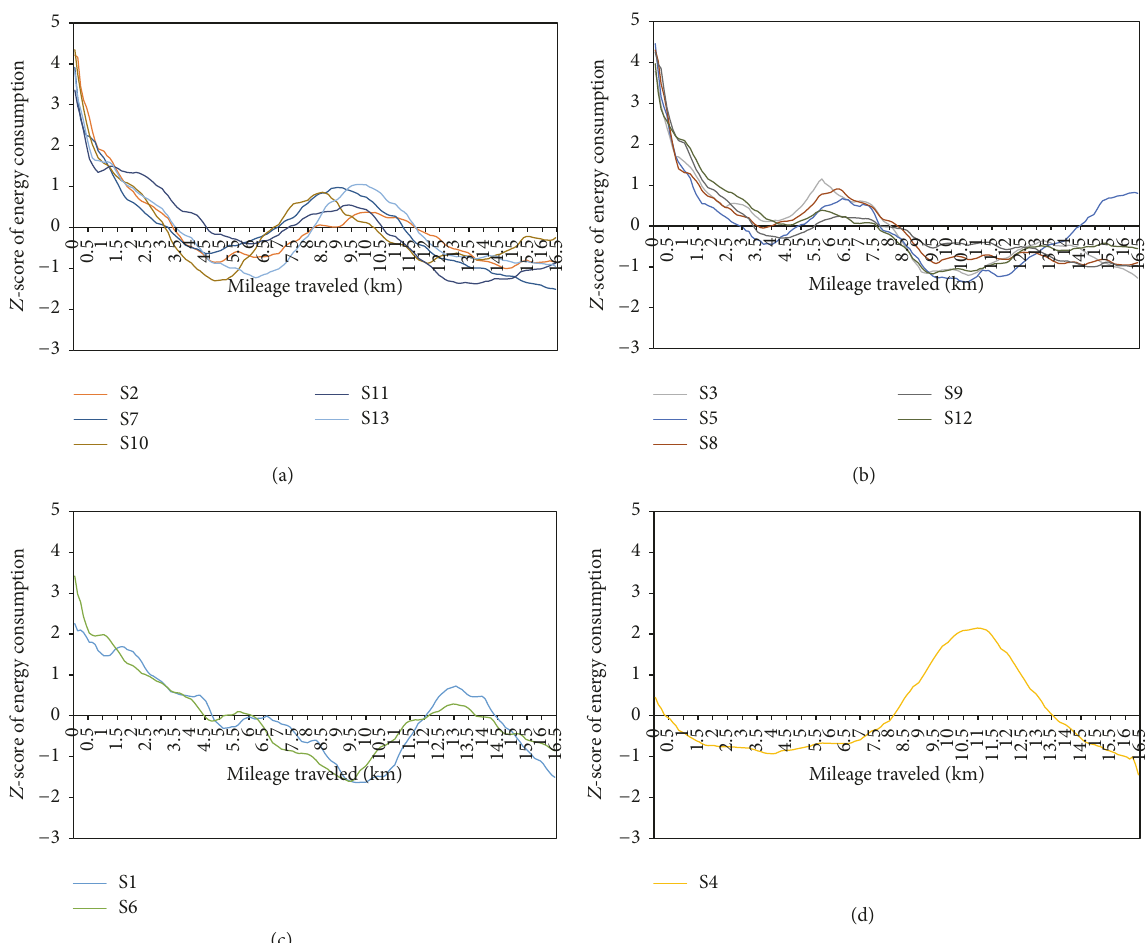
Figure 12: Energy consumption pattern for different clusters in congested traffic condition: (a) Cluster A: S2, S7, S10, S11, and S13; (b) Cluster B: S3, S5, S8, S9, and S12; (c) Cluster C: S1 and S6; (d) anomaly: